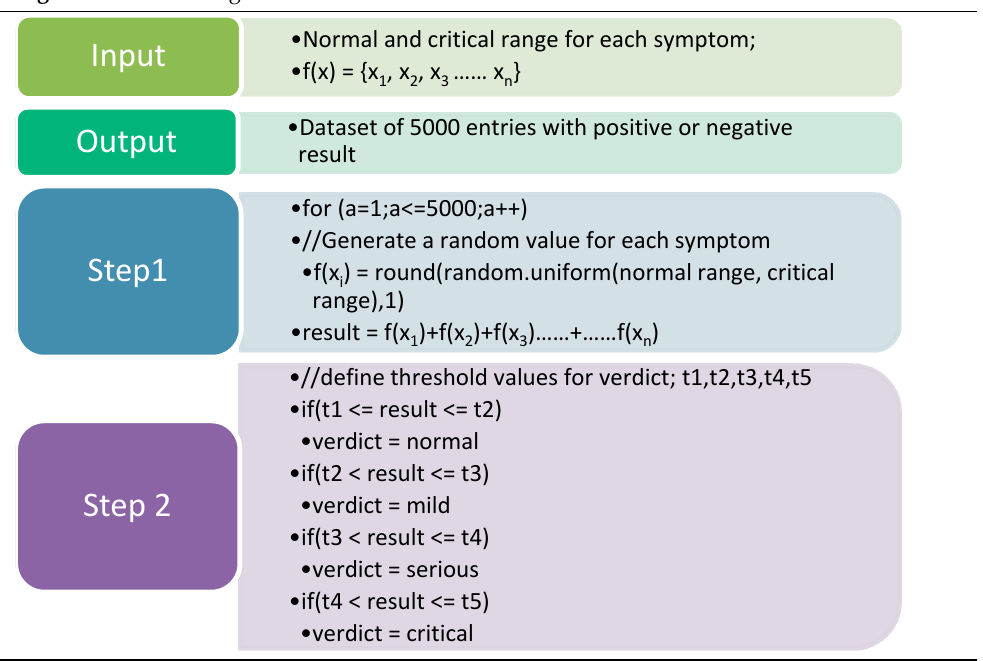
Algorithm 1. Dataset generation.